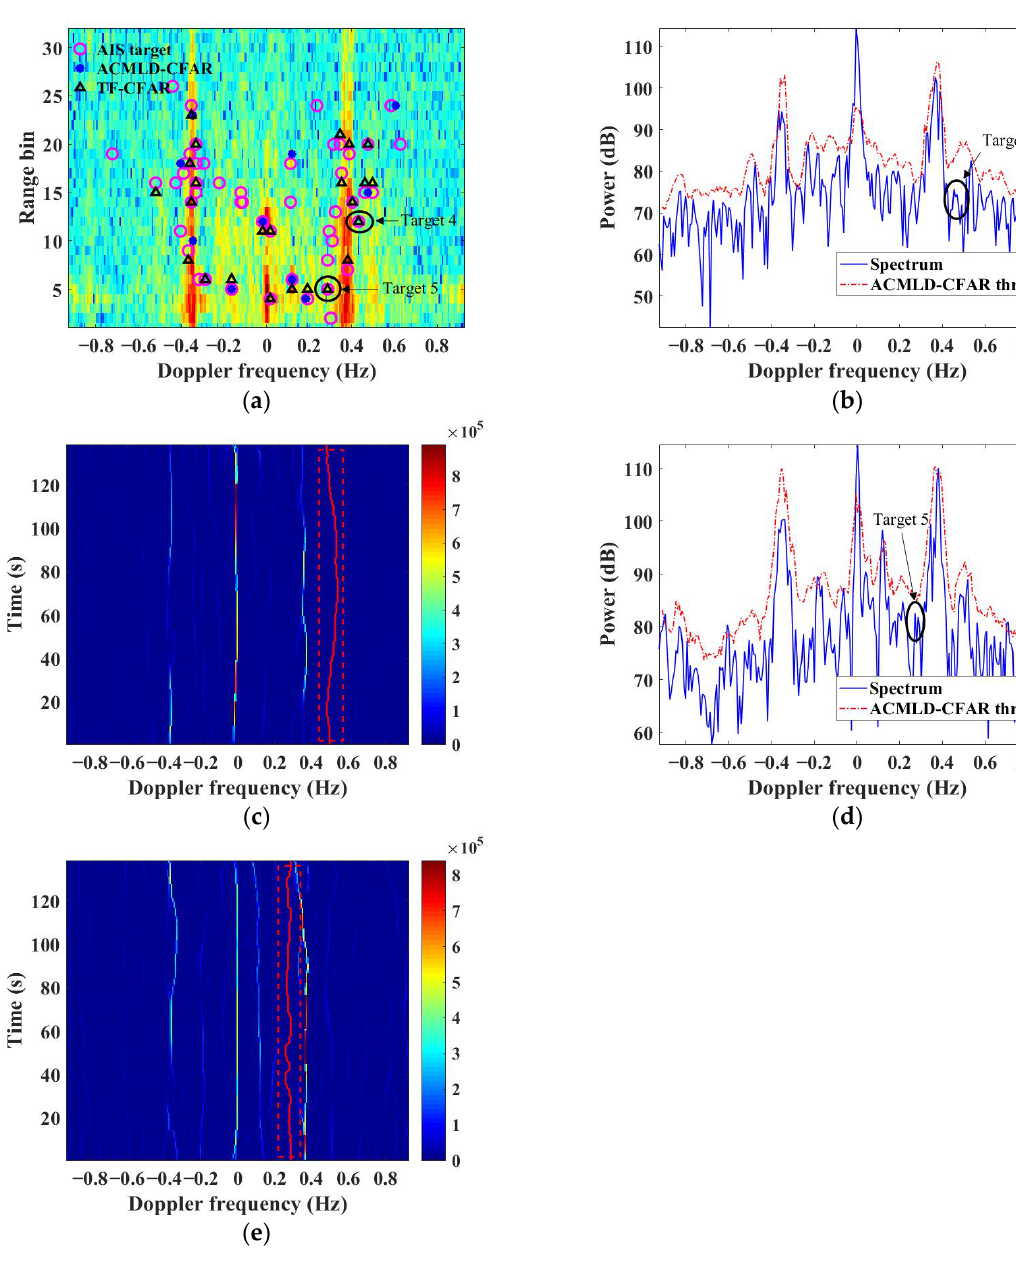
Figure 10. Target detection by ACMLD-CFAR and TF-CFAR at the edge of Bragg region at 00:07 on 5 October 2015 and ( b – e ) are from ACMLD-CFAR and TF-CFAR, respectively. ( a ) target matching map on RD; ( b ) power spectrum at the 12th range bin; ( c ) TF image at the 12th range bin; ( d ) power spectrum at the 5th range bin; ( e ) TF image at the 5th range bin.